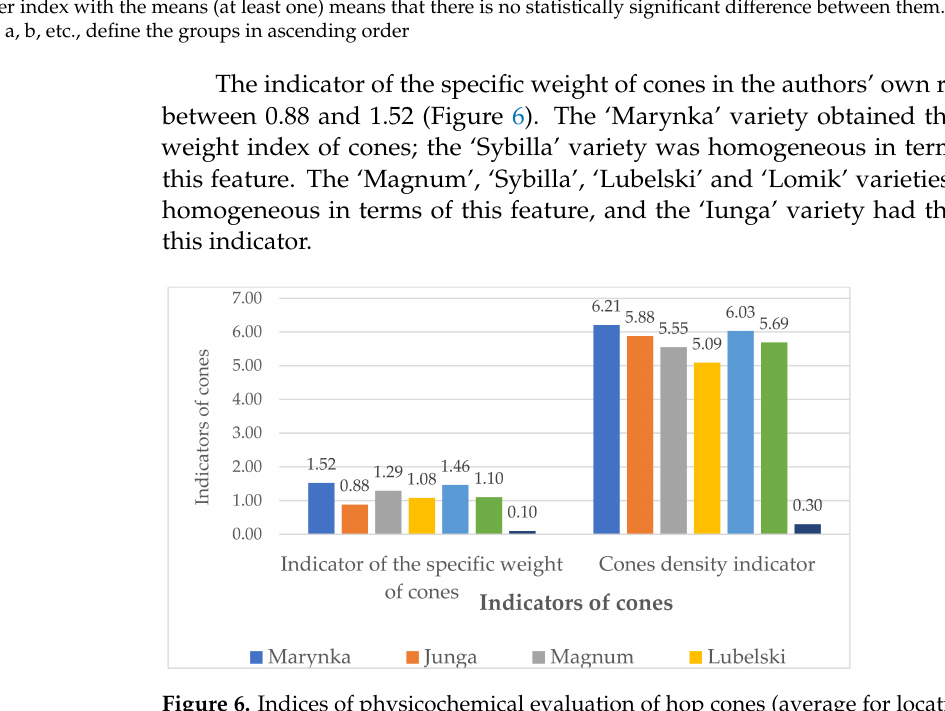
Figure 6. Indices of physicochemical evaluation of hop cones (average for location and